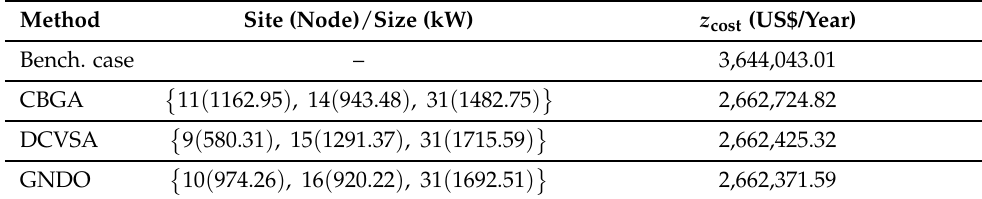
Table 4. Application of the GNDO approach to the location and sizing of PV generation in the 33-bus grid and comparison of results with literature